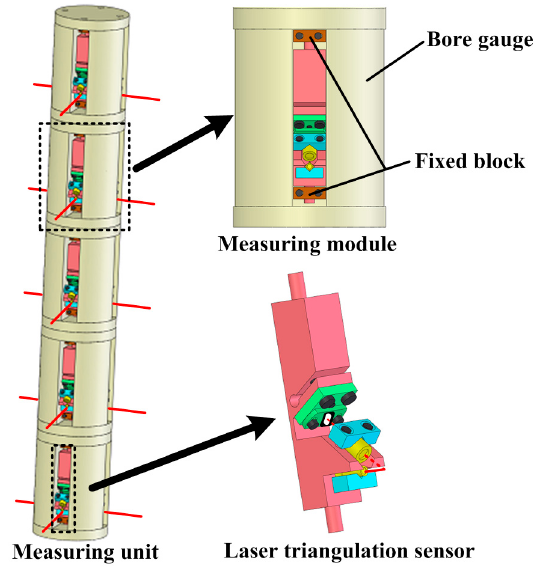
Figure 3. The measuring unit.